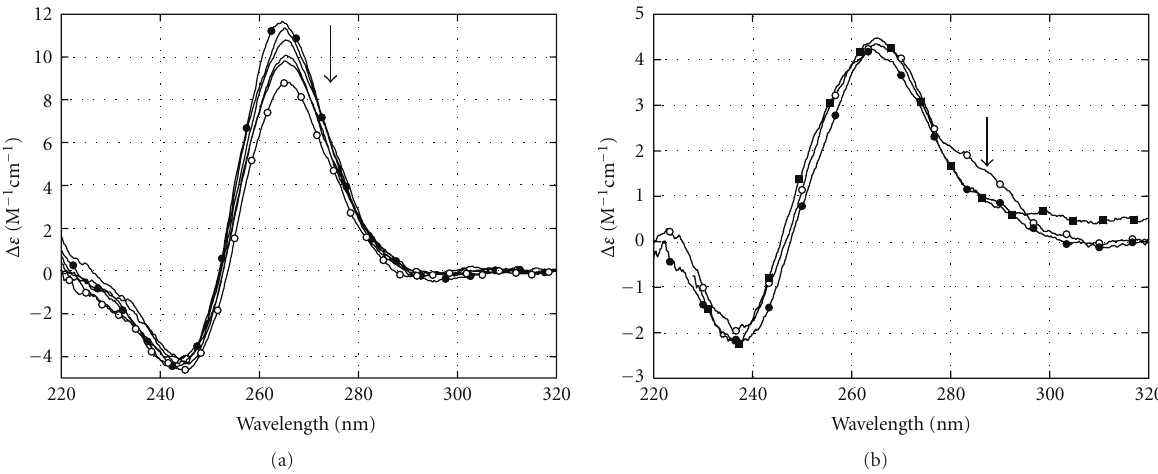
Figure 5: CD spectra of G-c- Myc and c- Myc duplex at di ff erent AIC concentrations: (a) CD spectra of free G-c- Myc (filled circles) and in complex with 3 AIC molecules (open circles). The concentration of G-c- Myc was 1 μ M; the concentrations of AIC corresponded to r = 0;0 . 5;1 . 14;2 . 0;2 . 5; ∼ 3 . 0 Hanks’ bu ff er, t = 20 ◦ C. (b) CD spectra of Pu18 c- Myc duplex (0.5 μ M): free (open circles), in complexes with 3 AIC molecules (filled circles) and in the presence of an excess of AIC (12 molecules; filled squares).